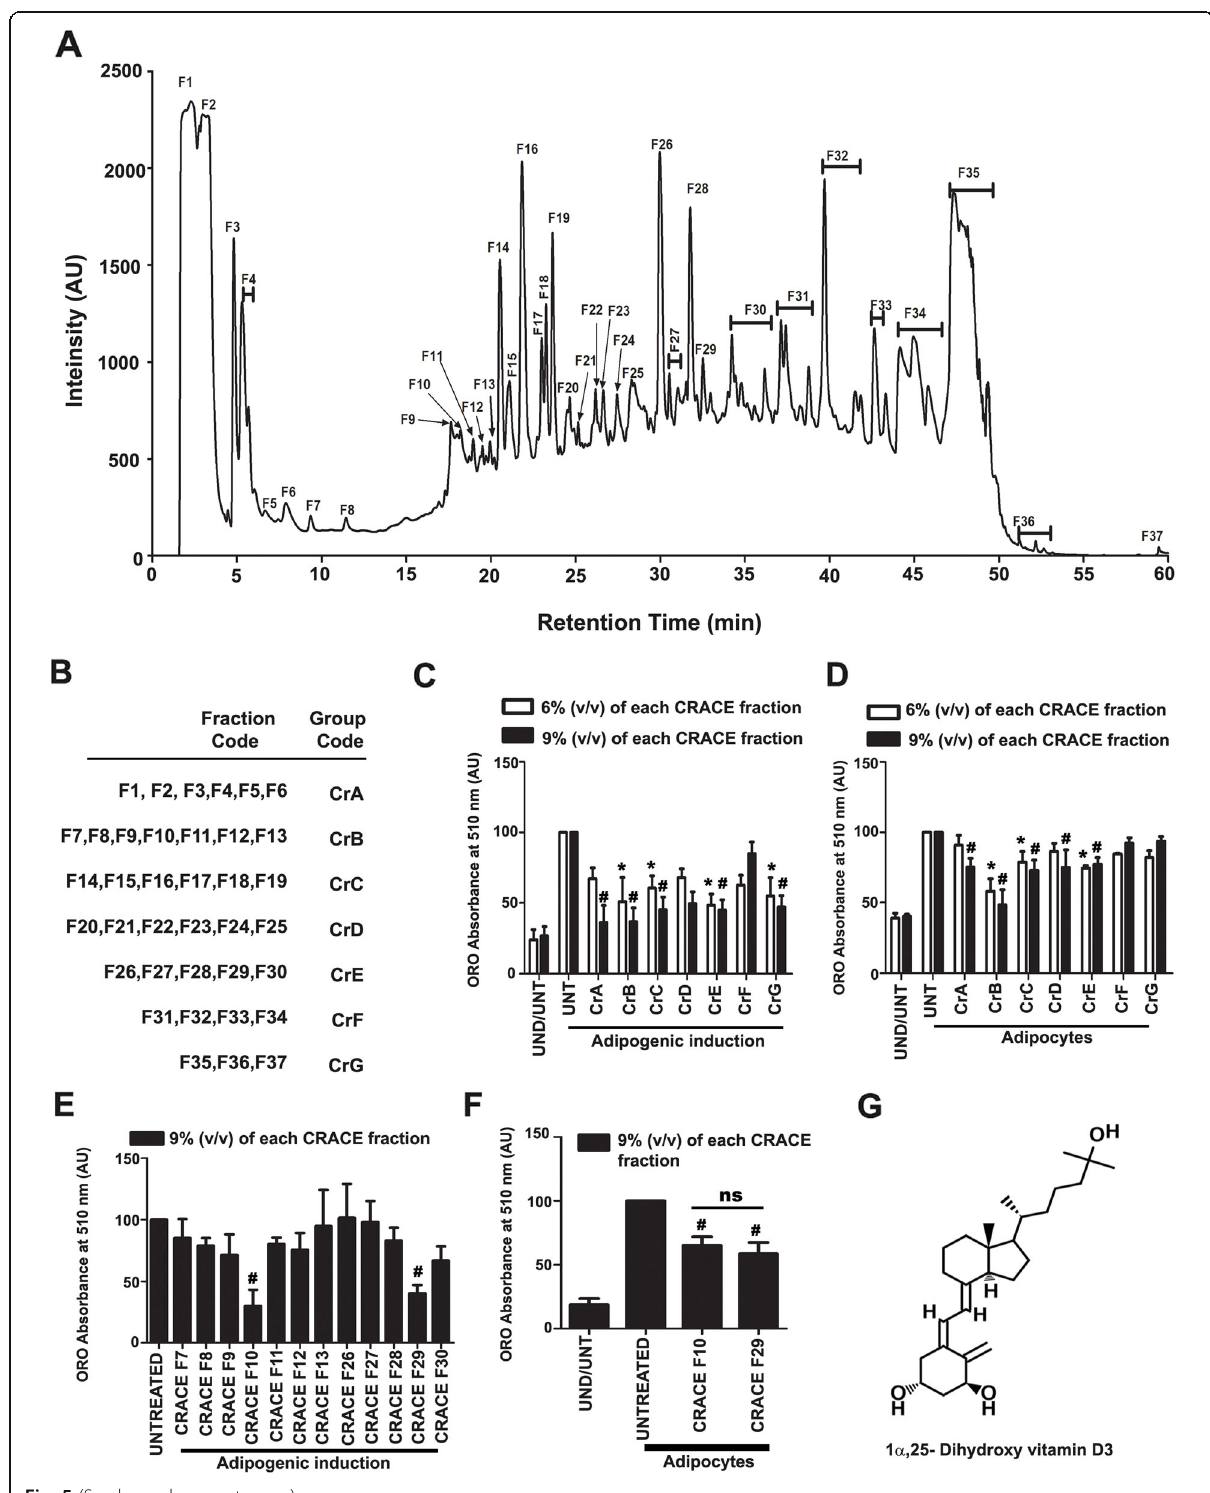
Fig. 5 (See legend on next